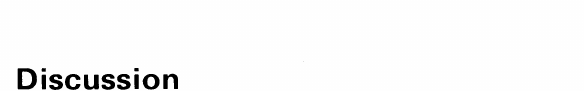
FIG. 3. Effect of pretreatment of neutrophils with hrTNF- and hrlL-8 on neutrophil migration induced by FMLP. Cytokines were used at final concentration of 10-7M and washed out prior to the use in microchemotaxis assay. Results are reported as means +_ S.E.M. of the number of neutrophils per field. (*p < 0.01, Student’s t-test.)